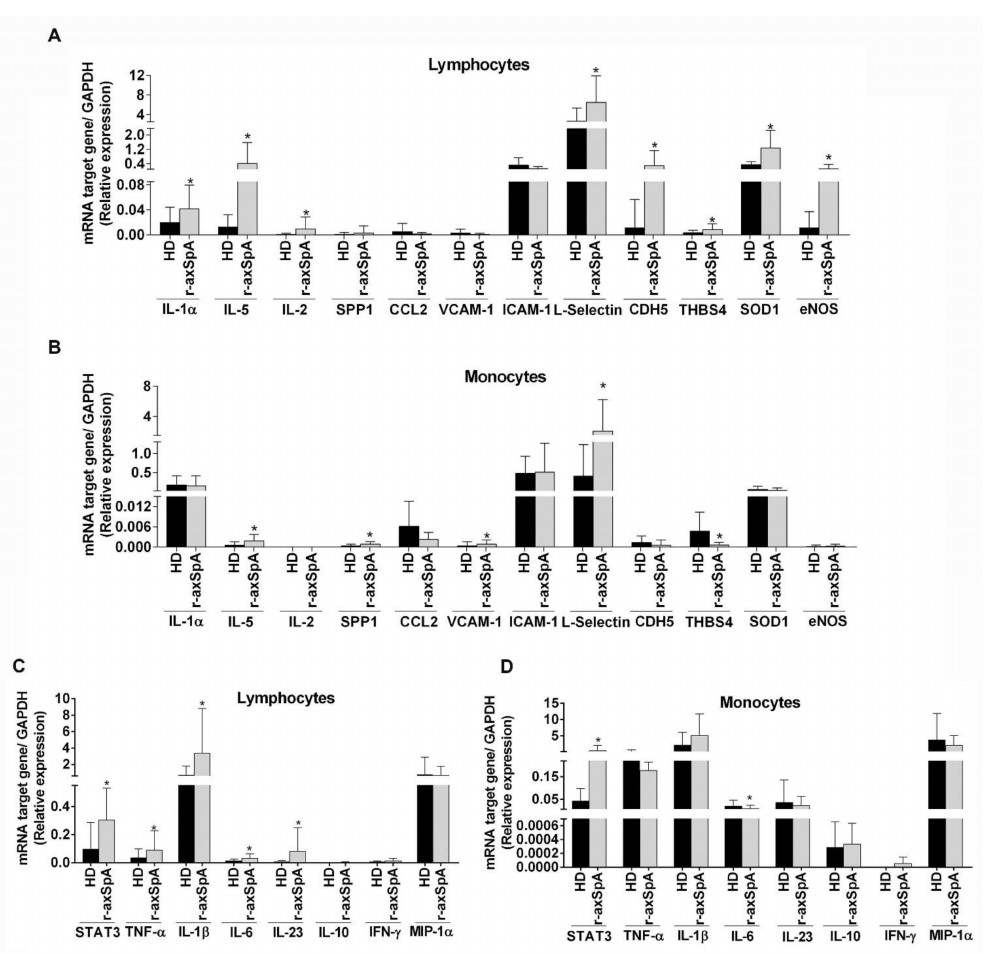
Figure 2. Study of atherogenic and inflammatory expression profile in lymphocytes and monocytes from r-axSpA patients. ( A , B ) Relative expression levels of atherogenic genes in lymphocytes ( A ) and monocytes ( B ) (HDs, n = 32; r-axSpA patients, n = 30). ( C , D ) Relative expression levels of inflammatory genes in lymphocytes ( C ) and monocytes ( D ) (HDs, n = 32; r-axSpA patients, n = 30). ( A – D ) Values are presented as means ± SD. The data were analyzed using an independent samples t -test or a Mann–Whitney U test. * vs. HDs ( p < 0.05). CCL, C–C motif chemokine ligand; CDH, cadherin; eNOS, endothelial nitric oxide synthase; HDs, healthy donors; ICAM, intercellular adhesion molecule; IFN, interferon; IL, interleukin; MIP, macrophage inflammatory protein; r-axSpA, radiographic axial spondyloarthritis; SOD, superoxide dismutase; SPP, secreted phosphoprotein; STAT, signal transducer and activator of transcription; THBS, trombospondin; TNF, tumor necrosis factor; VCAM, vascular cell adhesion